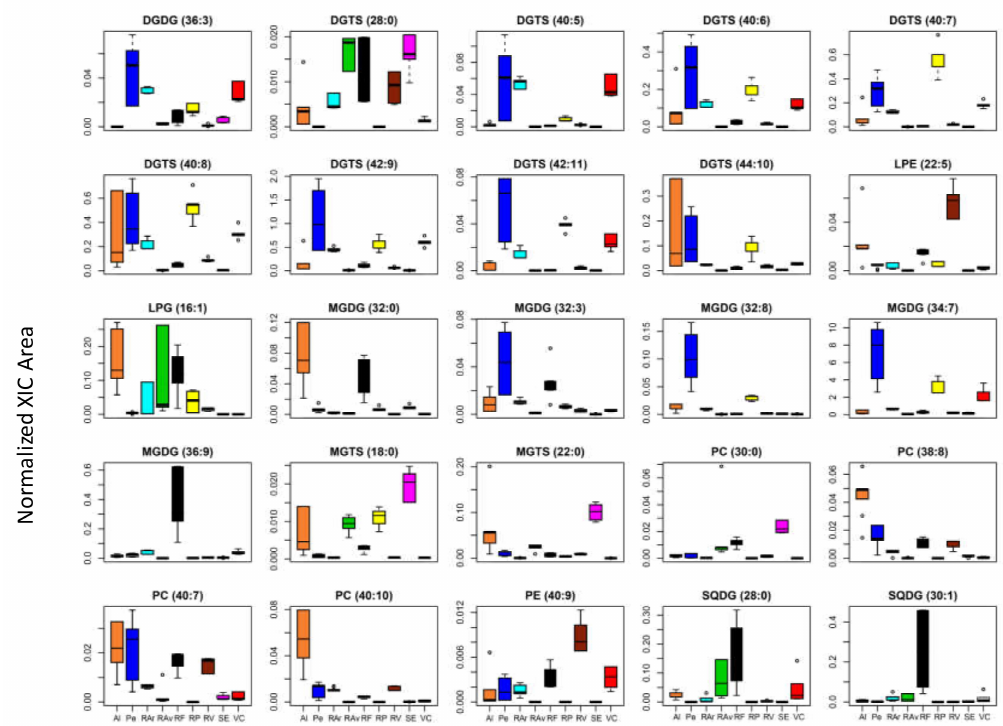
Figure 4. Boxplots of the top 25 lipid species sorted by Tukey’s HSD test displaying the lowest q-values. Normalized areas were obtained from extracted-ion chromatogram (XIC). Albufeira (Al), Peniche (Pe), Ria Arousa (RAr), Ria de Aveiro (RAv), Ria Formosa (RF), Ria de Pontevedra (RP), Ria de Vigo (RV), Sado Estuary (SE), and Viana do Castelo (VC). Labels of lipid species are according to the notation: AAAA (C:N), (AAAA, lipid class; C, total carbon atoms; N, total double bonds of fatty acid